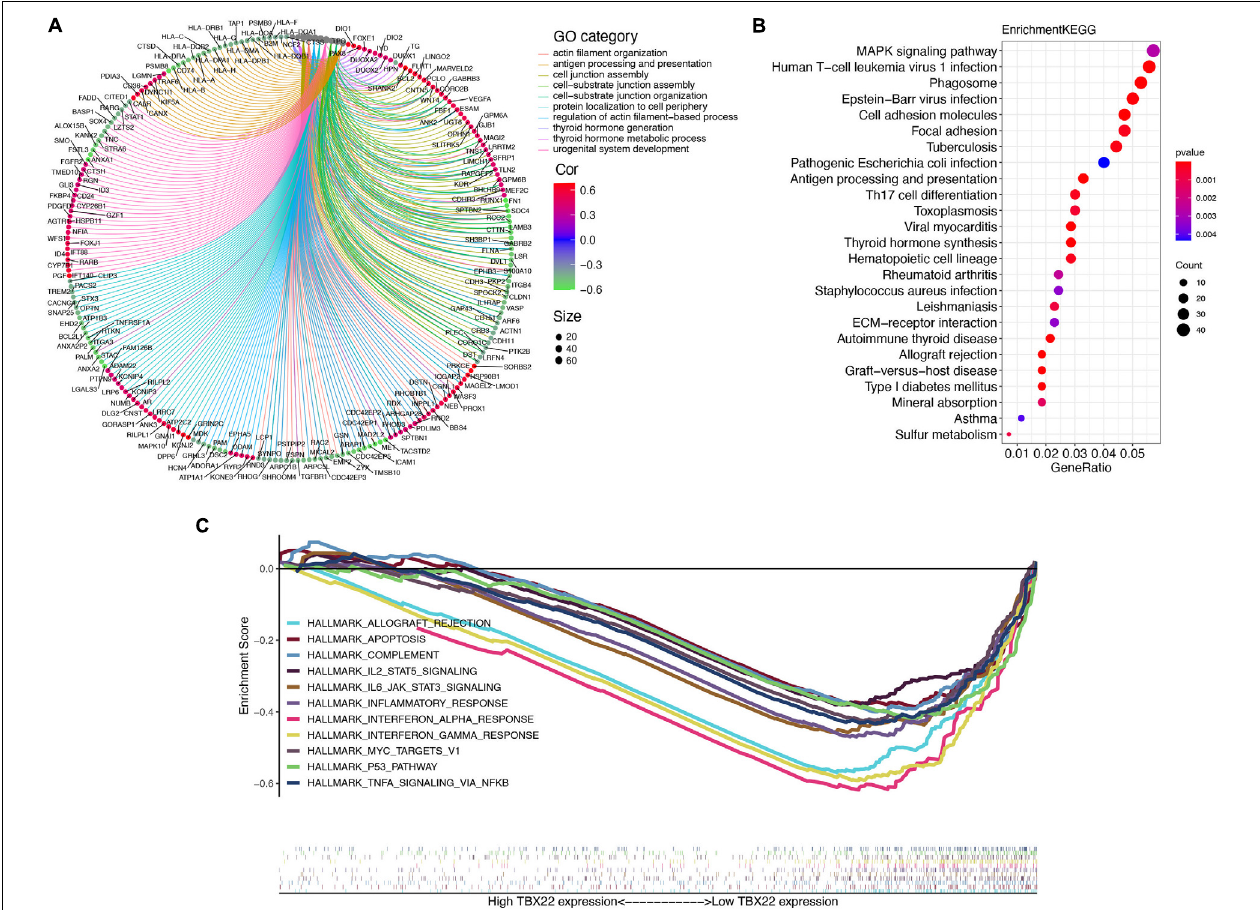
FIGURE 5 | Organization of TBX22 co-expressed genes and functional enrichment analysis. (A,B) Gene ontology (A) and KEGG pathways (B) were significantly correlated with TBX22 expression of thyroid hormone metabolism, immune activation, and MAPK signaling pathways. The top TBX22 co-expressed genes are shown (ranked by Spearman correlation value). (C) GSEA analyses displayed key pathways enriched in low (down) TBX22 expression subset. The complete lists are given in Supplementary Tables 2–5